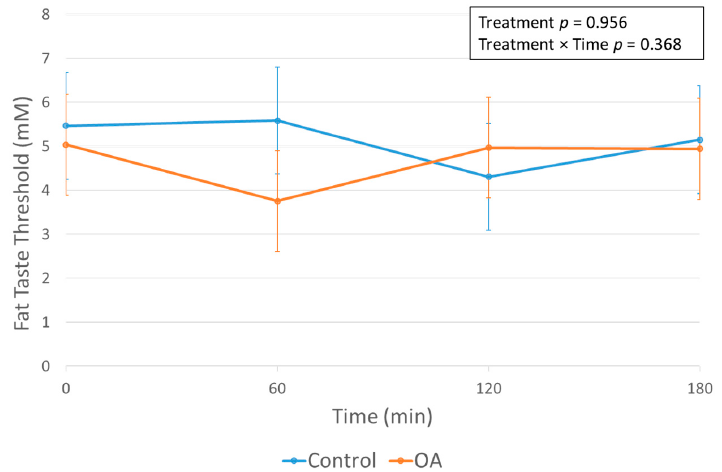
Figure 5. Means and SE bars for fat taste thresholds (FTT) in participants ( n = 31) prior to and following mouth rinse treatments over time. Data were only collected during days 1 and 2 of testing. Means and SE bars, and p -values were estimated by using a linear mixed model including treatment, time, and treatment × time interaction as fixed effects; the participant was used as a mixed effect to control for duplicate measures of each treatment.